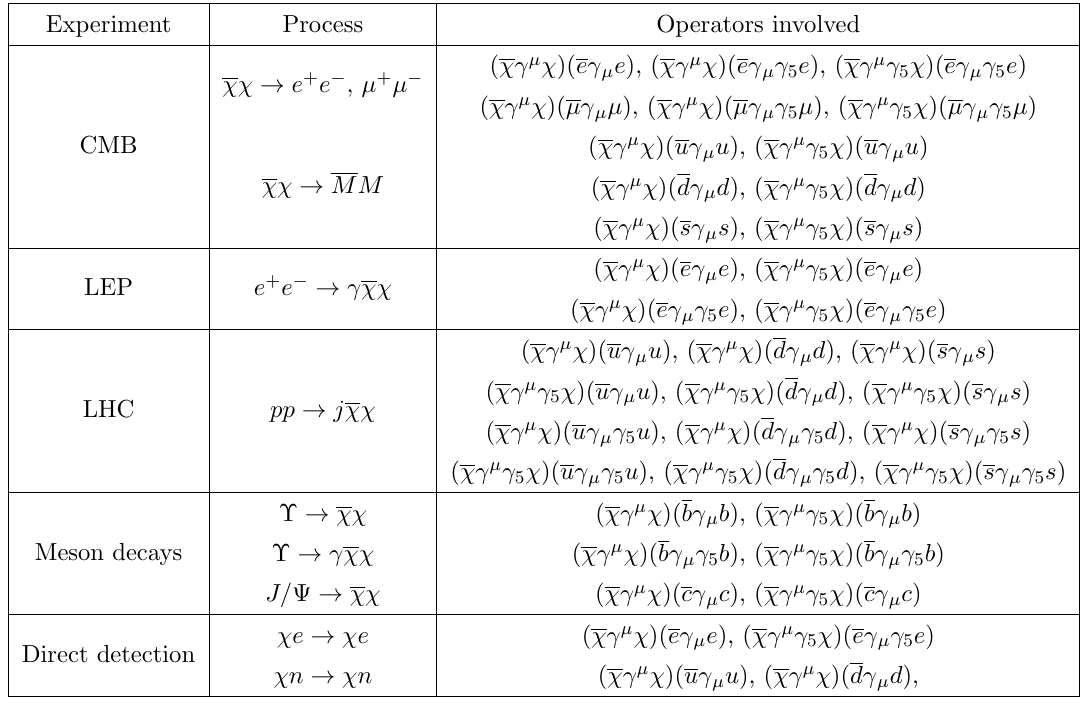
Table 1 . Experimental constraints and operators probed. The (cid:31)(cid:31) ! MM process refers to the DM annihilation into mesons (see appendix for